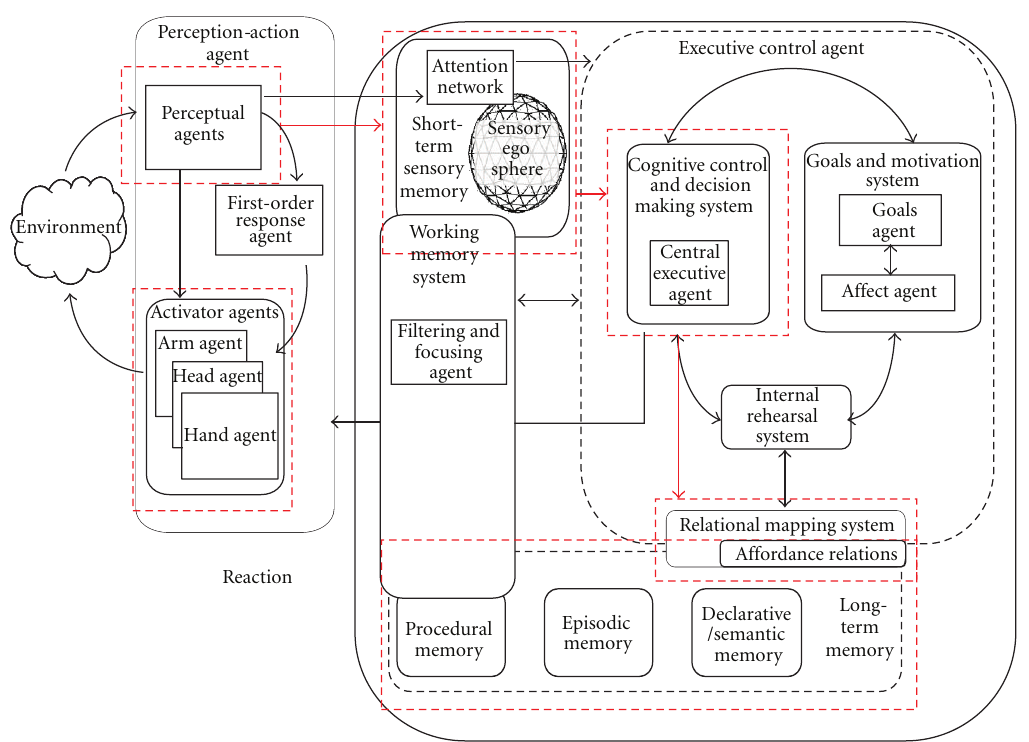
Figure 6: Learning stage in ISAC cognitive architecture.